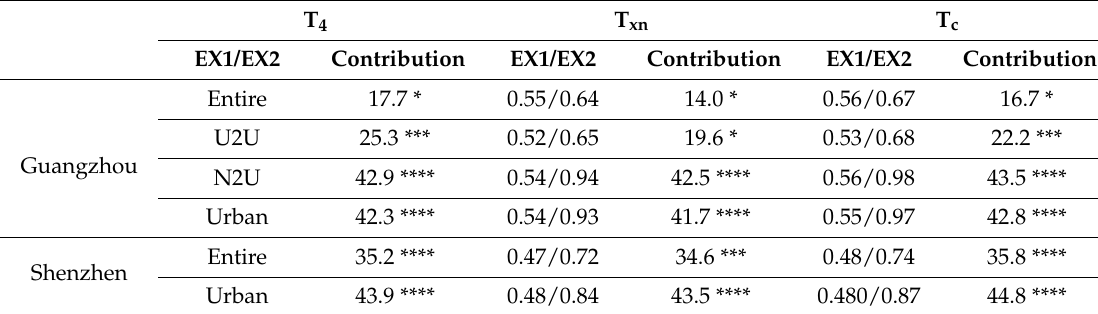
Table 3. Trends (units: ◦ C/decade) in annual mean SAT calculated using T 4 , T xn , and T c for EX1 and EX2, and the urban-related warming contributions (units: %) over the subregions of Guangzhou (the entire, U2U, N2U, and urban areas) and Shenzhen (the entire and urban areas). T 4 T xn T